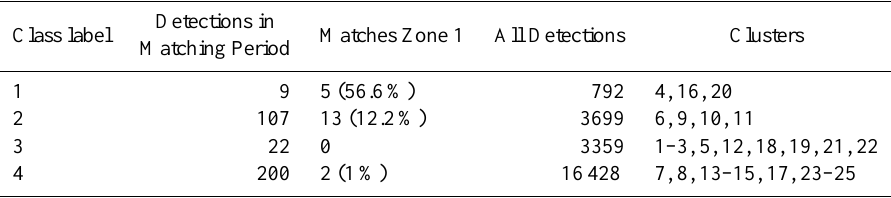
Table 2. Event classes obtained from clustering and defined based on matching seismic detections and visual observations. Class 1: clear glacier events related to calving, Class 2: most likely glacier events, Class 3: maybe glacier events, Class 4: no glacier events. “Detections in Matching period” is the number of seismic detections during the matching/ground-truth period. “Matches Zone 1” is number (and percentage) of seismic detections which can be related to a direct observation in Zone 1. “All detections” refers to seismic detection within entire time of seismic recording in 2009 and 2010. The last column states the clusters merged to define classes (see Fig. 3b, c). Detections in Class label Matches Zone 1 All Detections Clusters Matching